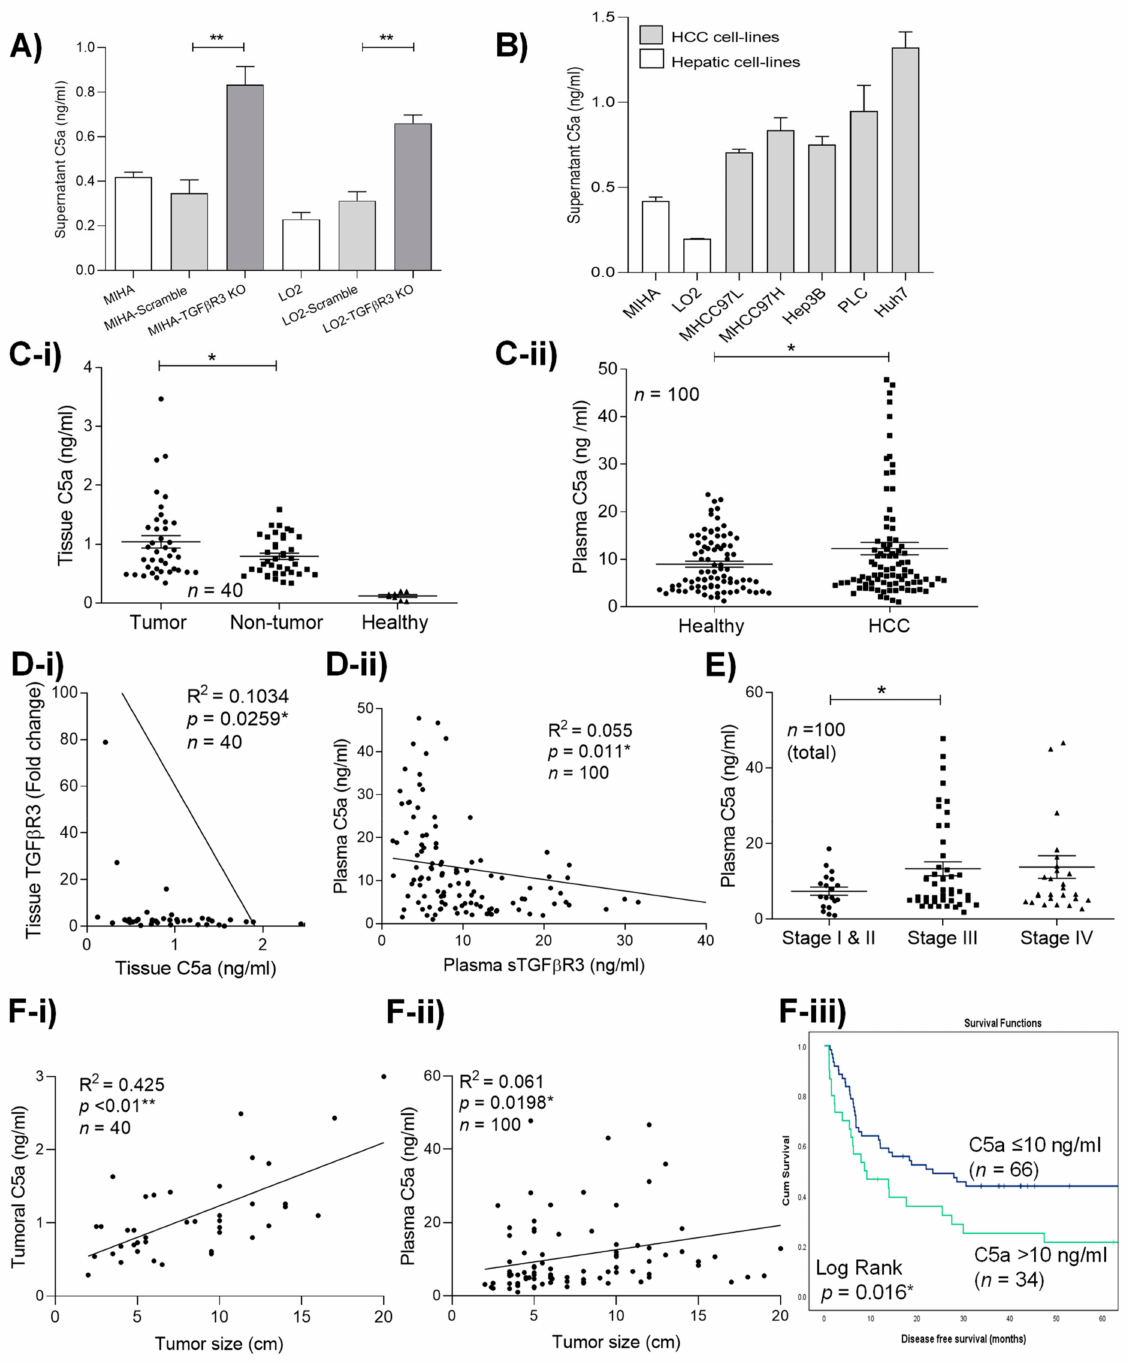
Figure 4. Loss of TGF β R3 induced the upregulation of C5a in HCC. ( A ) TGF β R3 transcript analysis of two non-HCC hepatocyte cell lines, MIHA and LO2, knock-out by CRISPR/Cas9 (MIHA-TGF β R3 KO) and (LO2-TGF β R3 KO). Level of secretory C5a in ( B ) hepatocyte and HCC cell lines. ( C-i ) Tumoral, adjacent non-tumoral and healthy liver tissue, ( C-ii ) healthy and HCC patients’ plasma. ( D-i ) Correlation analysis of tissue TGF β R3 and C5a. ( D-ii ) Correlation analysis of plasma C5a and sTGF β R3. ( E ) Level of plasma C5a HCC patients with different tumor stages. Correlation analysis of tumor size with the level of ( F-i ) tumoral and ( F-ii ) plasma C5a. ( F-iii ) Kaplan–Meier analysis of disease-free survival in HCC patients associated with plasma C5a. * p < 0.05, ** p < 0.01. Error bar indicated SEM. (Unpaired t -test for Figure 4A,B,C,E) (Chi-square test for Figure 4D,Fi-ii)(Log rank test for Figure